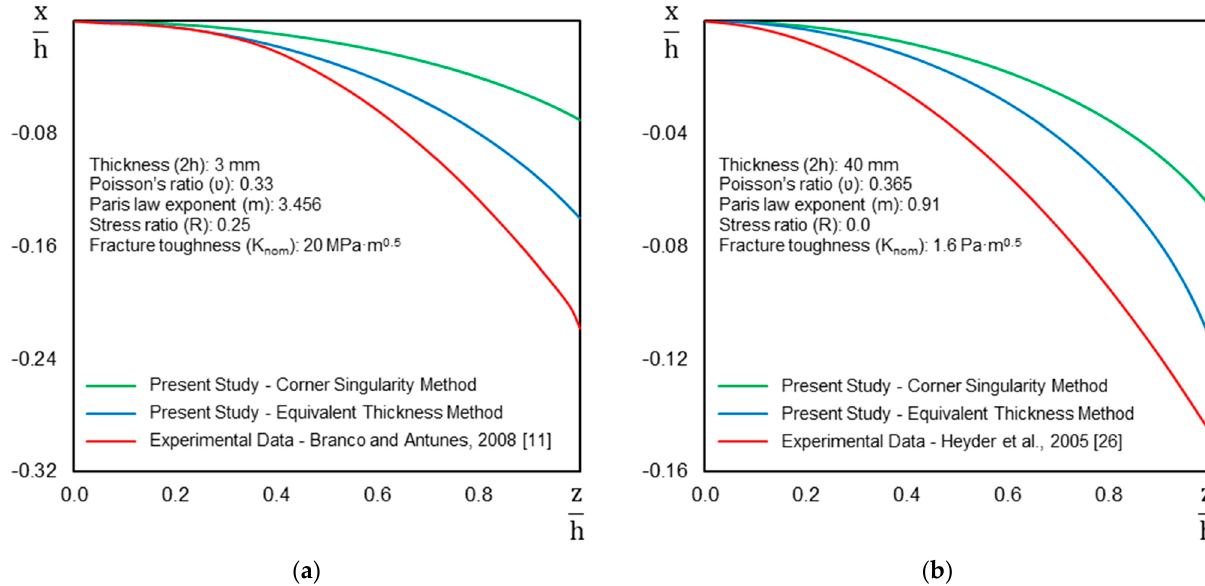
Figure 7. A comparison between the predicated crack shapes and experimental data for the specimens composed of: ( a ) 6082-T6 aluminium alloy and ( b ) polymethyl methacrylate.